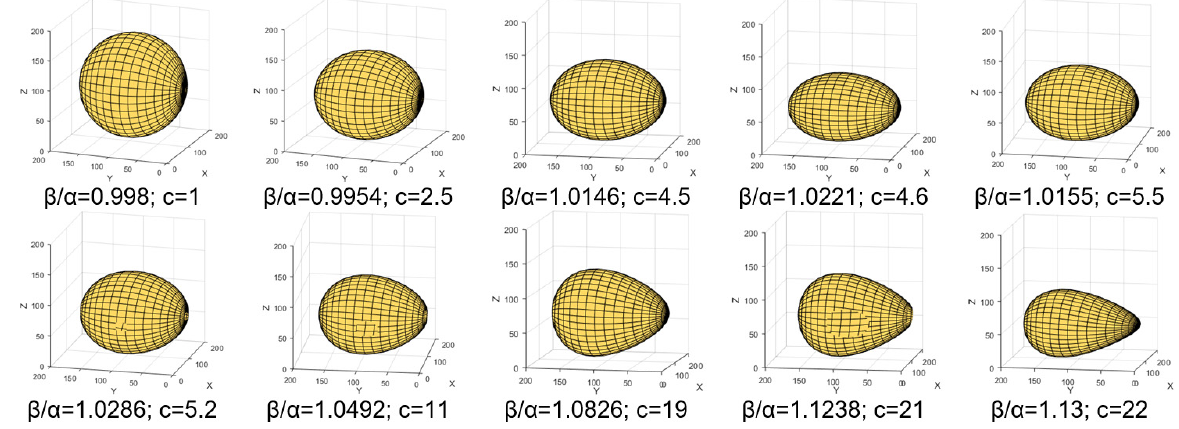
Figure 3. Basic 3D egg shapes.